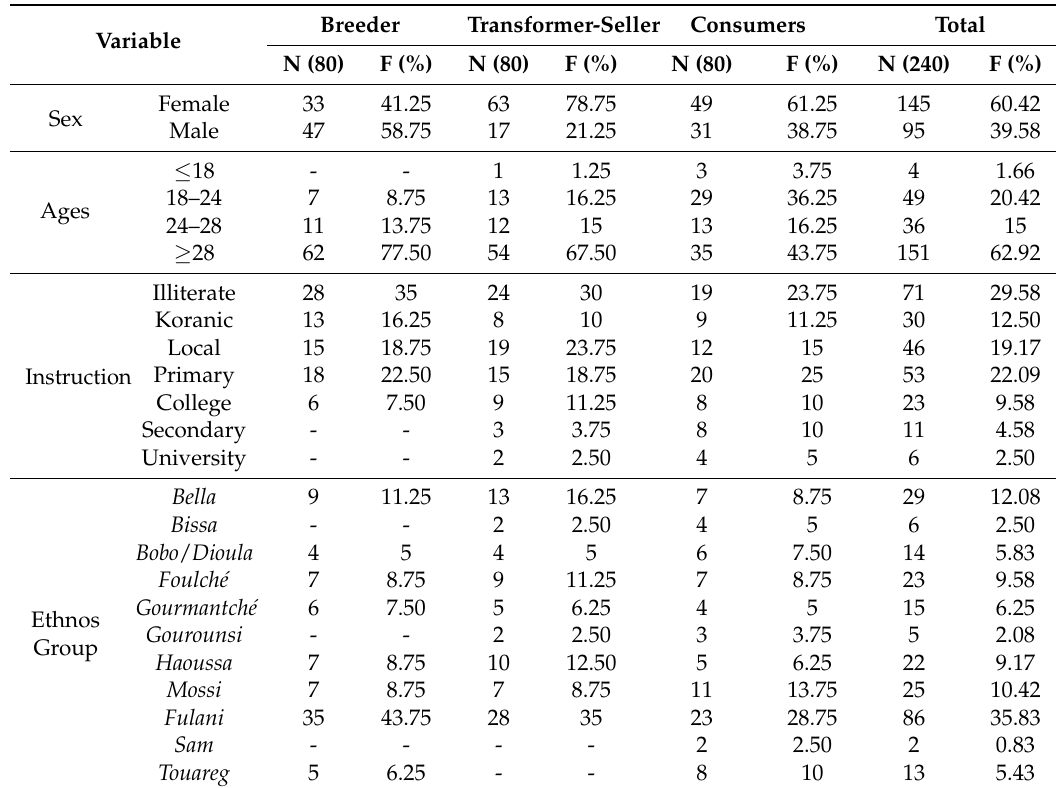
Table 1. Sociocultural characteristics of